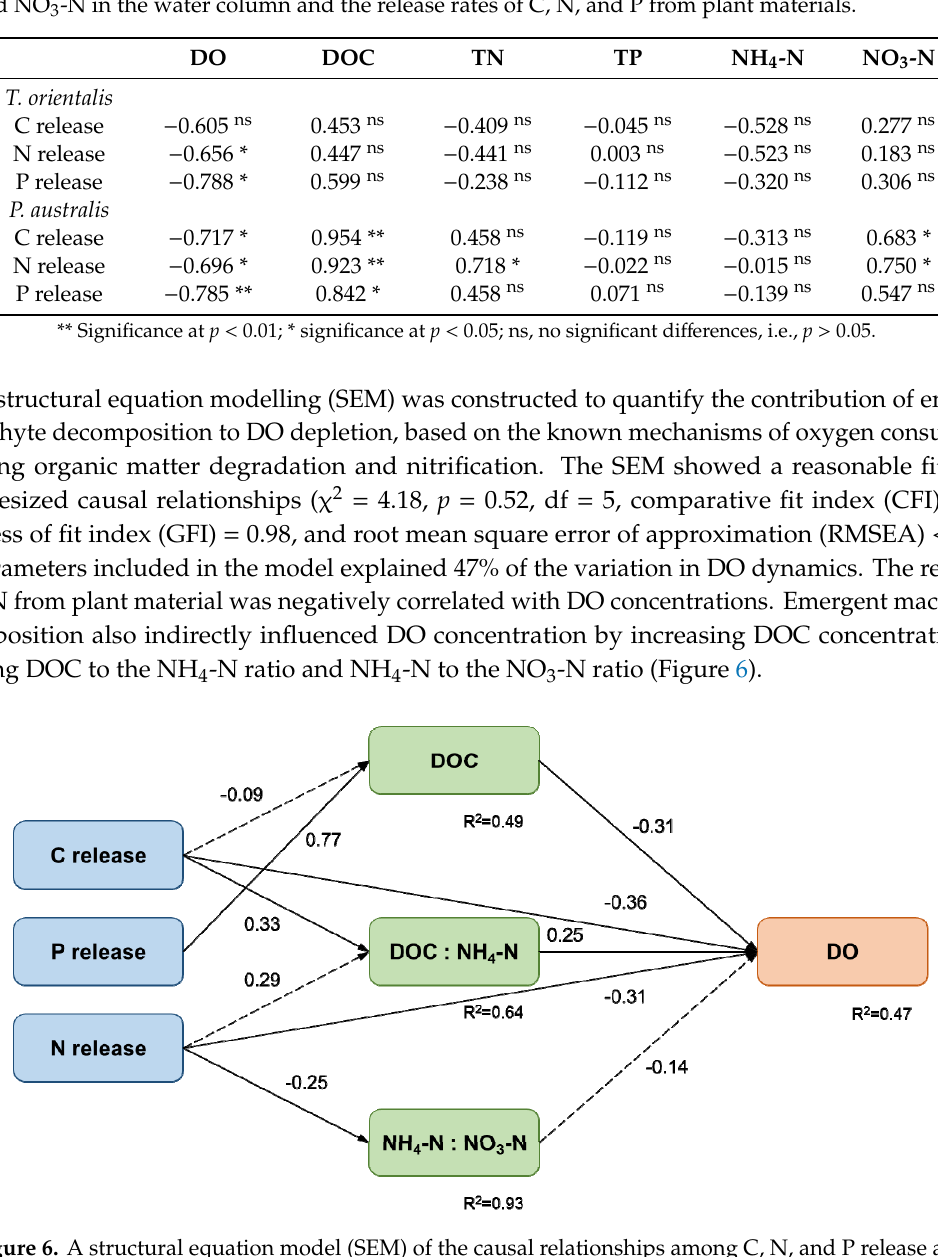
Figure 6. A structural equation model (SEM) of the causal relationships among C, N, and P release and DO, DOC, NH 4 -N, and NO 3 -N dynamics in the water column: the solid and dashed lines indicate significant ( p < 0.05) and nonsignificant effects, respectively. The numbers above arrows are path coefficients. The R 2 values represent the proportion of variance explained for each endogenous variable.